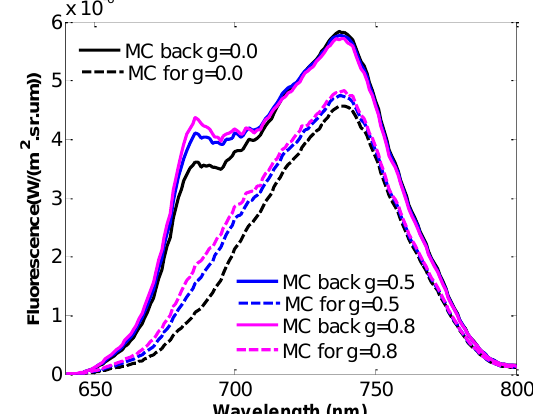
Figure 4. Simulated leaf backward (MC back) and forward (MC for) fluorescence by the MC model with g of 0, 0.5, and 0.8